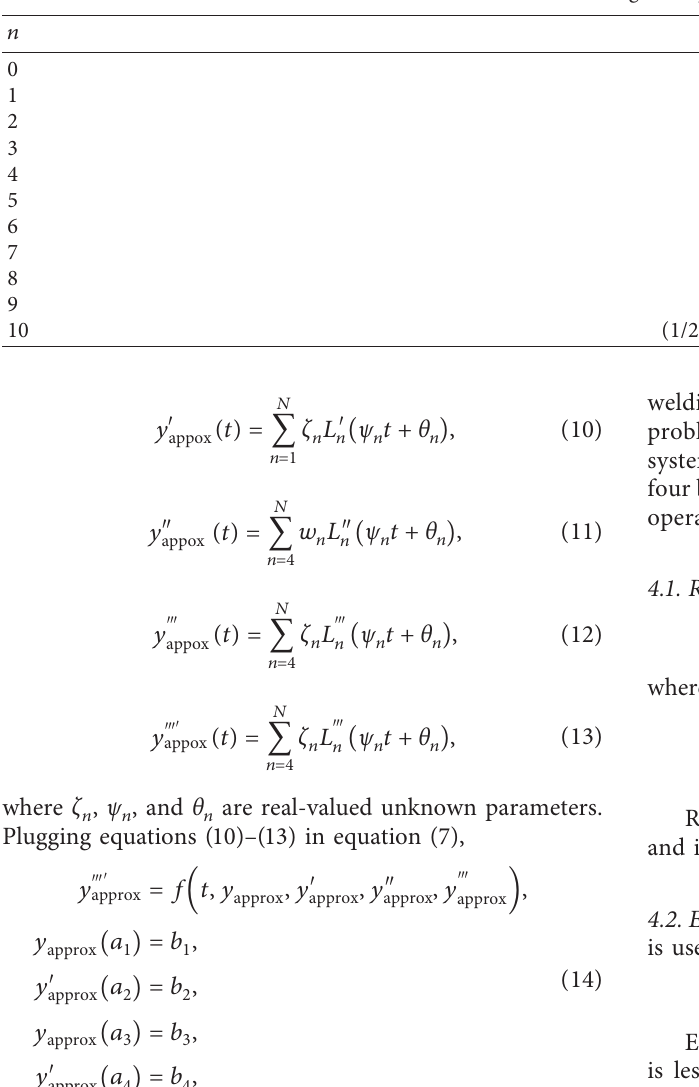
Table 4: First ten Legendre